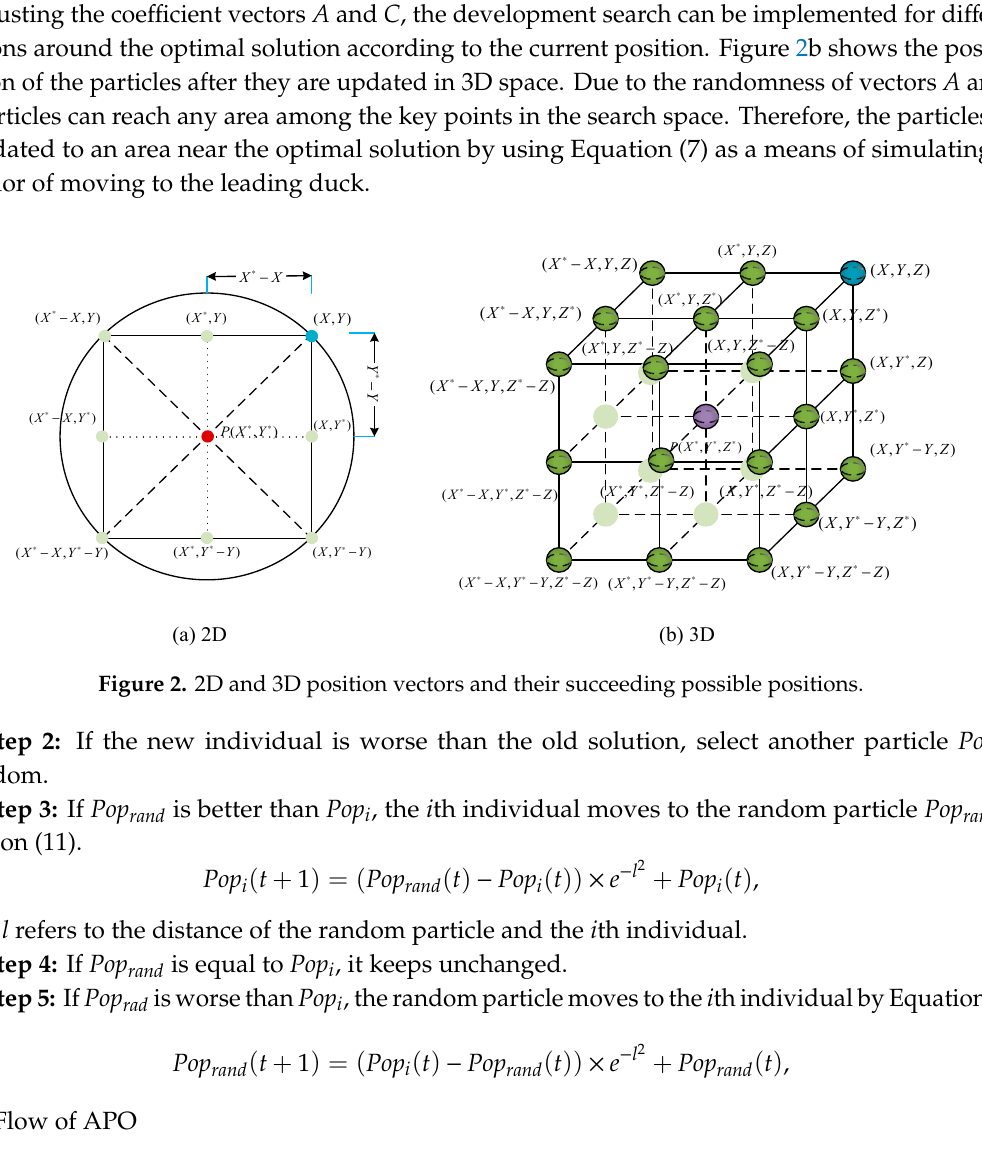
Table 1. Pseudo code of the anas platyrhynchos optimizer (APO).